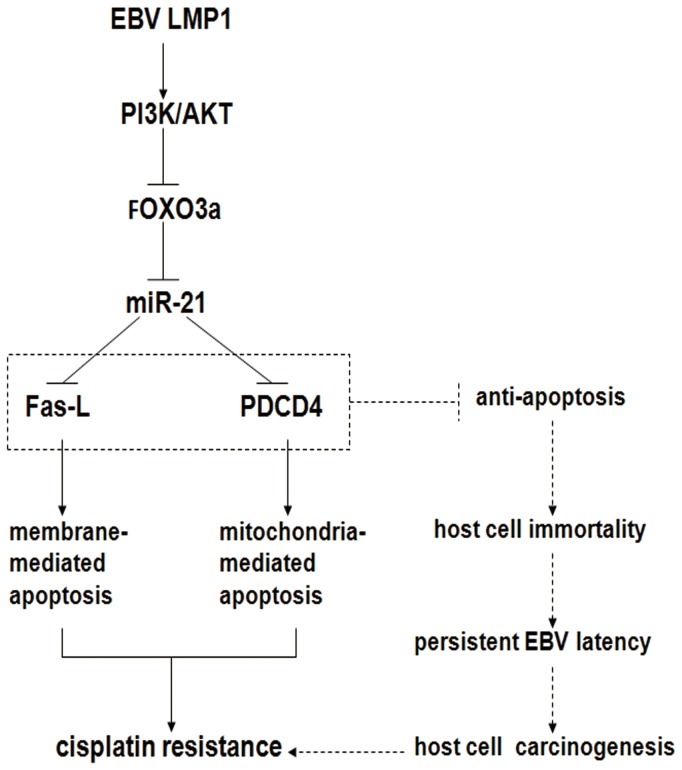
A proposed model for EBV LMP1-mediated miR-21 upregulation in the regulation of specific downstream targets and resulting cisplatin resistance in NPC cells.LMP1 activates the PI3K/AKT signaling pathway, which causes the phosphorylation of FOXO3a. Phosphorylated FOXO3a then translocates from the cytosol to the nucleus and will most likely be degraded. The reduction of FOXO3a in the nucleus results in miR-21 production, which, then functions to reduce PDCD4 and Fas-L expression. These proteins are involved in mitochondrial and membrane-mediated apoptosis, leading to resistance to apoptosis and cisplatin in NPC cells (indicated by the solid lines). The ability to protect host cells from apoptosis is essential for EBV to establish its persistent latent infection, and therefore proapoptotic PDCD4 and Fas-L are usually the key target genes regulated by EBV in latency (indicated by dashed lines). This newly discovered signaling pathway should provide potential drug targets for sensitizing cancer cells to apoptosis and overcoming chemoresistance in LMP1-activated NPC cells.